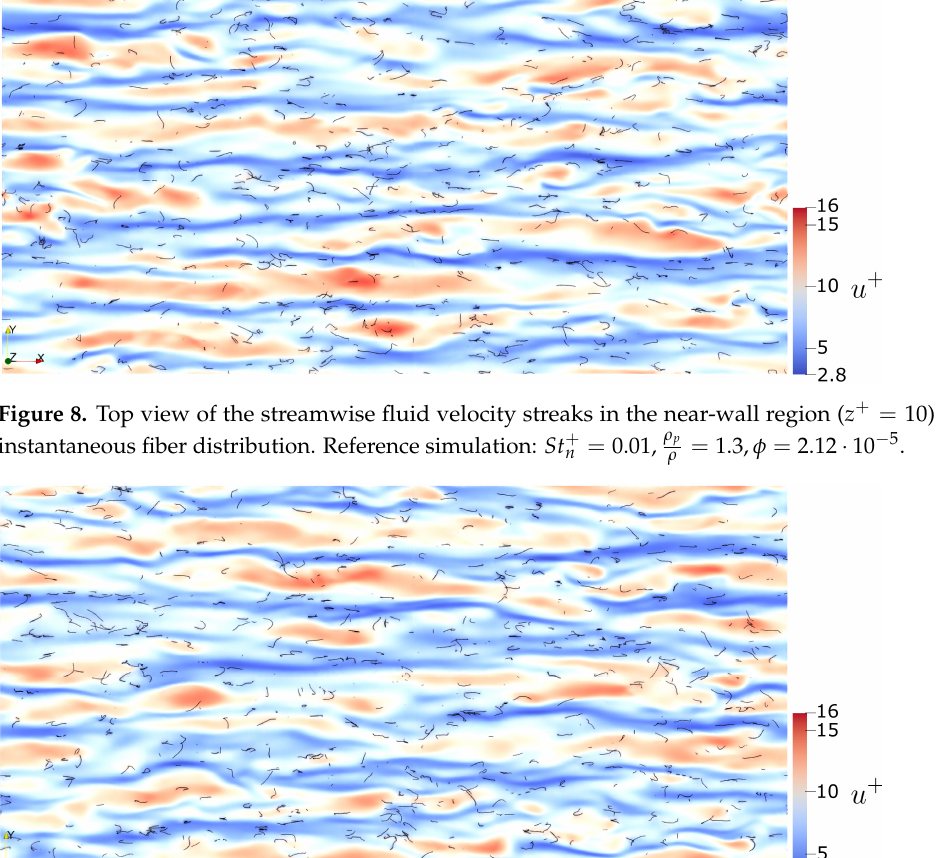
Figure 9. Top view of the streamwise fluid velocity streaks in the near-wall region ( z + = 10) and instantaneous fiber distribution. Reference simulation: St + n = 10, ρ p